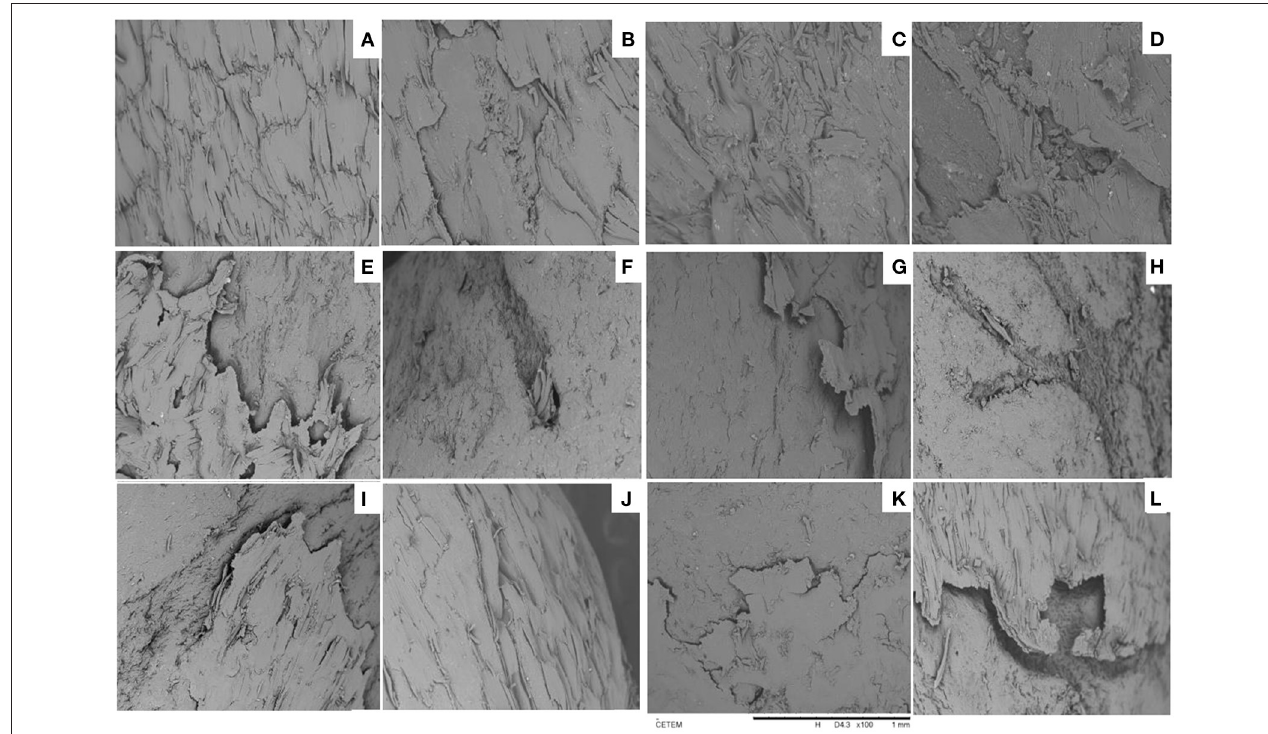
FIGURE 2 | Typical scanning electron micrographs of non-Jacu wet-processed crops 2016 and 2017 (A) , Non-Jacu dry-processed crop 2017 (B) , Jacu dry-processed crop 2016 (C) , Jacu dry-processed crop 2017 (D) , Sumatra Aceh Gayo dry-processed crop 2015 (E) , Sumatra Aceh Gayo dry-processed crop 2017